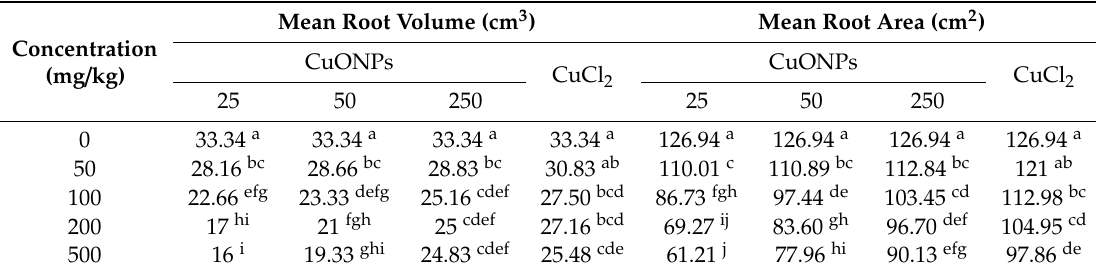
Table 5. E ff ect of CuONPs and CuCl 2 on root volume and root area of soybeans. Means with similar letters denote no significant di ff erence between the treatments according to the Fisher’s LSD test ( p ≤